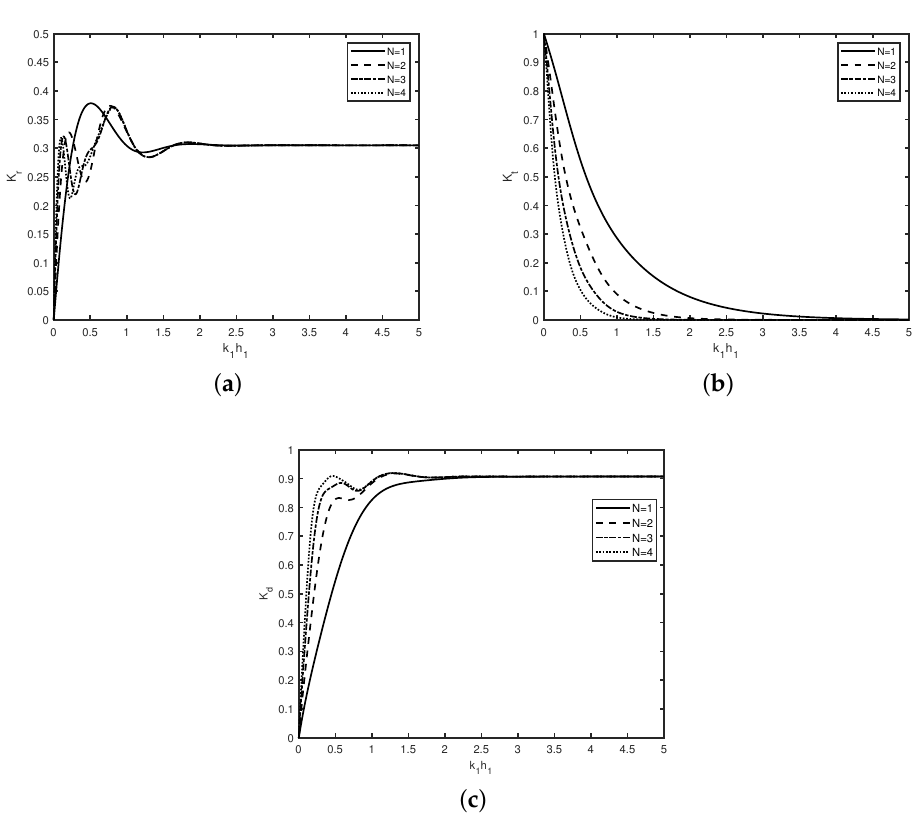
Figure 4. Variation of ( a ) reflection coefficient K r , ( b ) transmission coefficient K t , and ( c ) dissipation coefficient K d versus wavenumber k 1 h 1 for different N with C f = 1.5, w = h 1 , d = 2 h 1 , θ = 20 ◦ , h 2 = 0.25 h 1 , h 1 = 5 m.